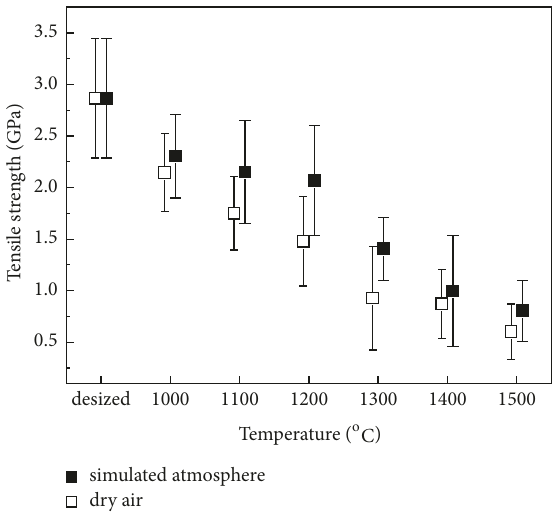
Figure 1: The tensile strength of KD-S fibres after annealing at 1000-1500 ∘ C for 1 h.